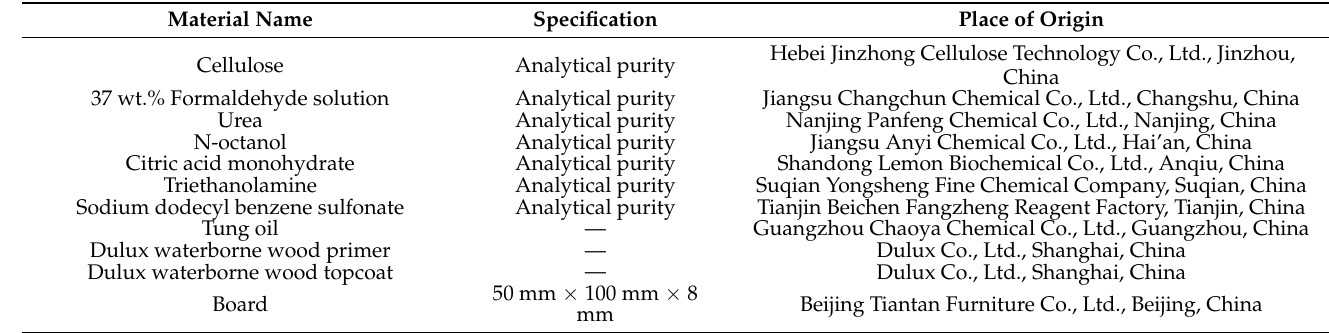
Table 1. List of chemicals and materials used in the